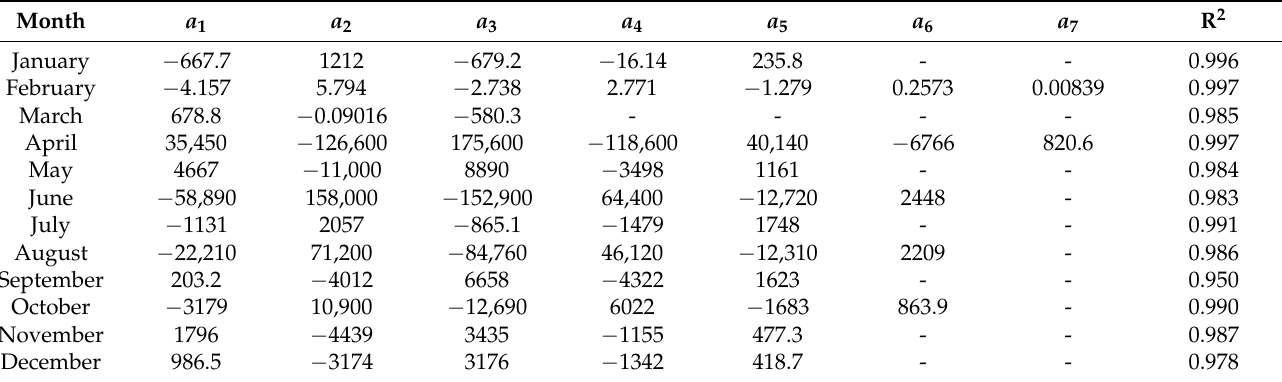
Table A4. Specific parameters of Wujiangdu section.